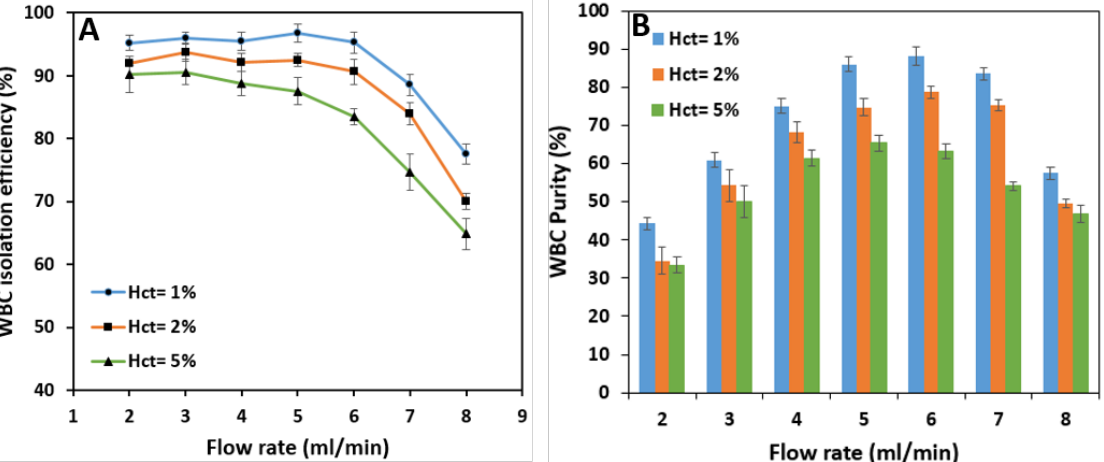
Figure 13. The effect of blood hematocrit on WBCs’: ( A ) isolation efficiency, ( B ) purity. Separation efficiency mainly decreases with an increase in blood hematocrit due to the rise in the effect of cell-cell interaction in higher flow rates. Sample purities for lower hematocrits are mainly higher since to amount of RBCs in the diluted sample is lower. WBC purity is higher at the inlet flow rates of 5, 6, and 7 mL/min due to an increase in RBCs removing ratio.